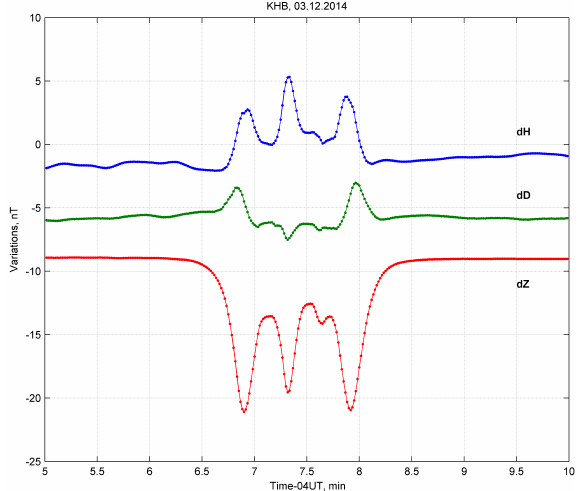
Figure 10. Noise-like interference caused by the faulty power sup- ply at the Khabarovsk observatory, manifested in the records of Overhauser magnetometer POS-1. (a) Daily record of F (POS-1) after elimination of natural geomagnetic variations by GSM-19W data; (b) behaviour of QMC (quality measurement criterion) instru- mental parameter of